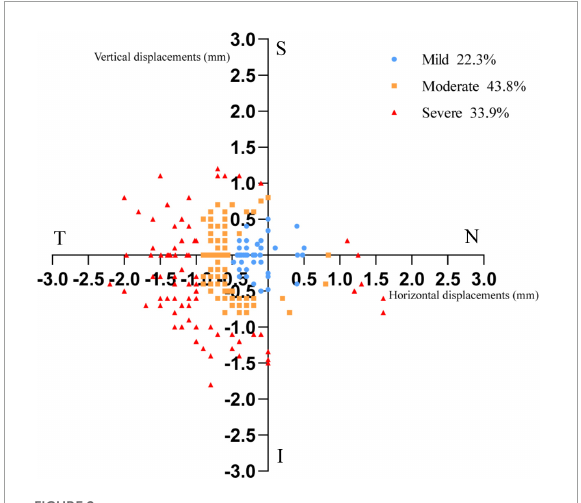
FIGURE2 The distribution of the center of the treatment zone for all subjects. Each point depicted in the figure represents the location of the center point of each subject’s treatment zone in an axis with the pupil center as the origin. Each plotted point shows the distance and angle of the center of treatment zone from the pupil center. The spacing of each grid on the coordinate axis represents 0.5 mm on the cornea. (T: temple; N: nasal; S: superior; I: